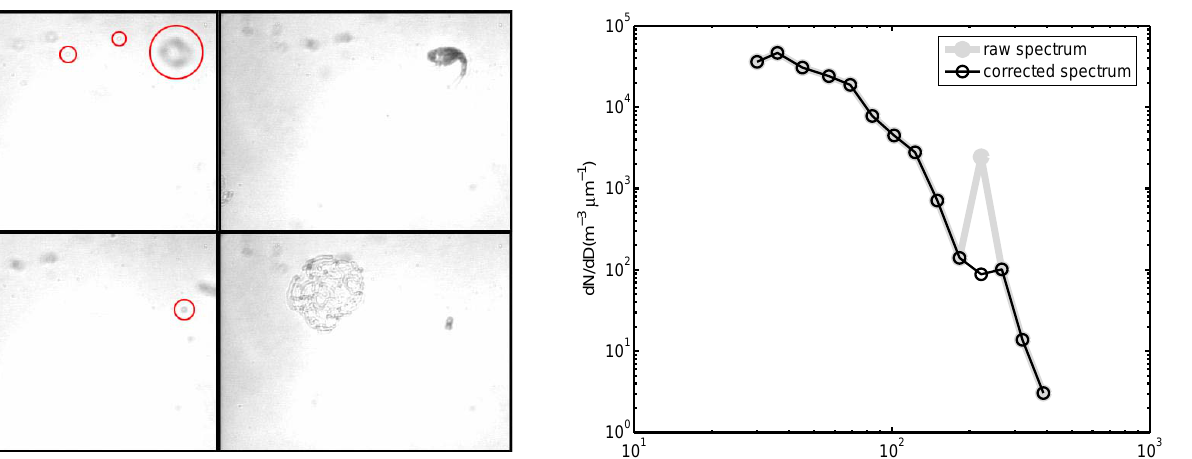
Fig. 3. Images from the bubble camera showing bubbles (circled in red), and a variety of marine biota.